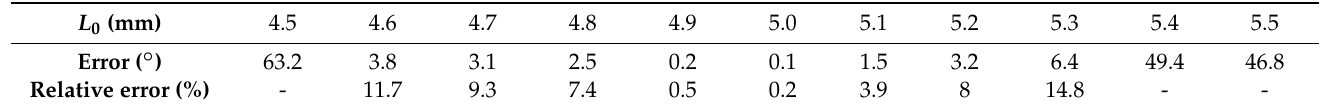
Table 13. Comparison between model calculation and HFSS simulation results when parameters of L 0